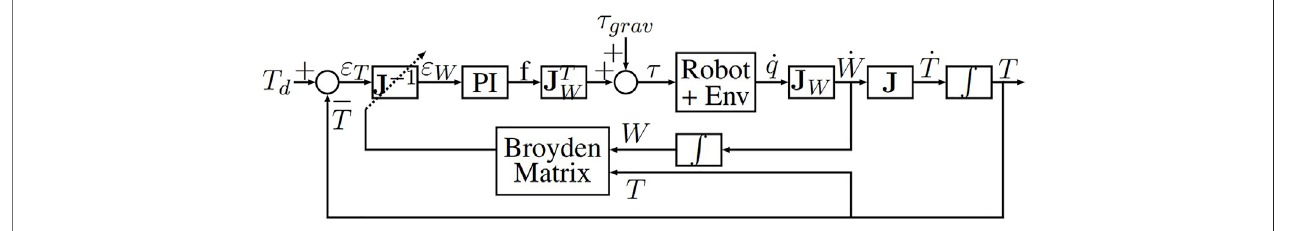
FIGURE 12 | Closed loop control of the Apollo robot for automatic fi ne movements of the instrument tip taking the elasticity of the environment into account.